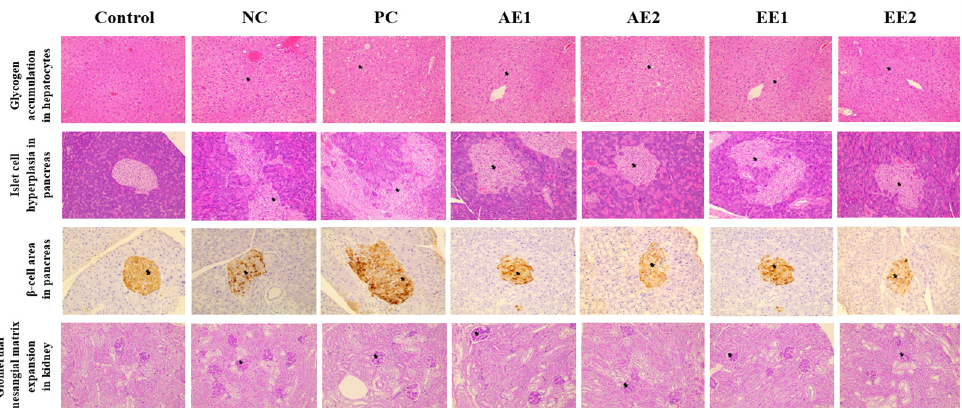
Figure 7. Effects of A. hookeri extracts on histopathological examination of the diabetic mice. Control: non-diabetic mice; NC: negative control; PC: positive control; AE1: aqueous extract 100 mg/kg BW; AE2: aqueous extract 200 mg/kg BW; EE1: ethanol extract 100 mg/kg BW; EE2: ethanol extract 200 mg/kg BW. AE and EE groups were treated with Allium hookeri extracts for 8 weeks. Data are presented as the mean ± SEM (n =